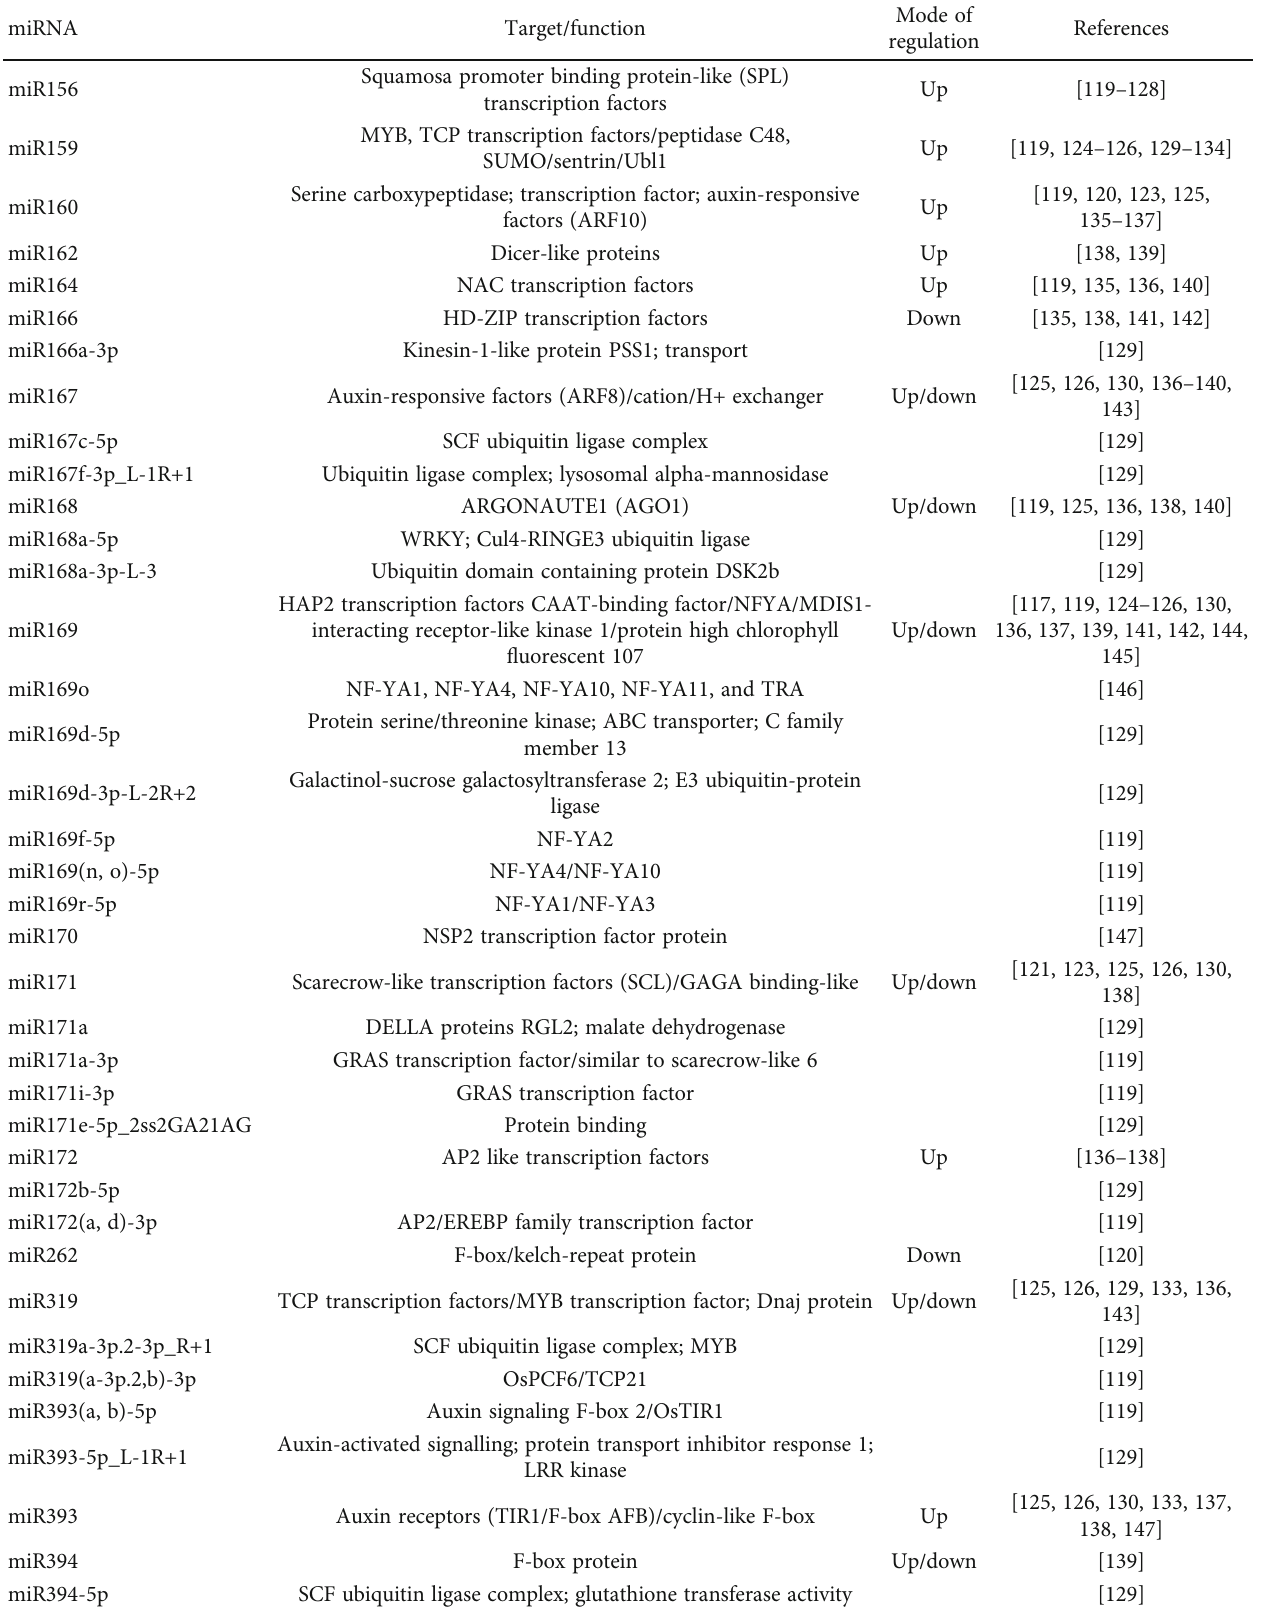
Table 1: Di ff erentially expressed miRNAs under nitrogen starvation